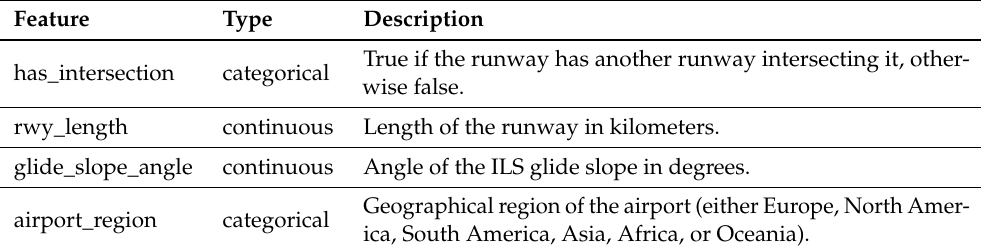
Table 3. Features used in the regression model to predict the probability of a GA of an airport–runway pair.